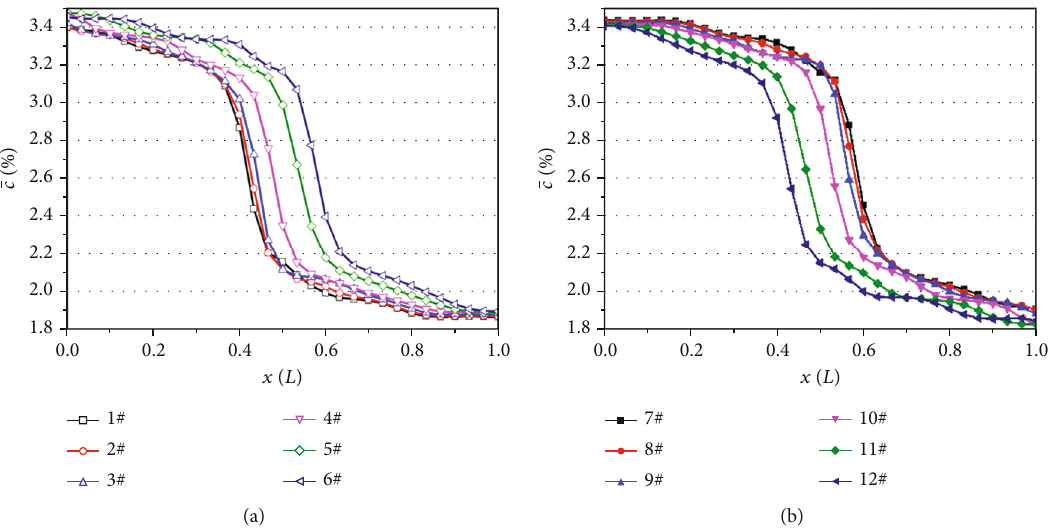
Figure 14: Variation of average salinity of the duct cross-section in